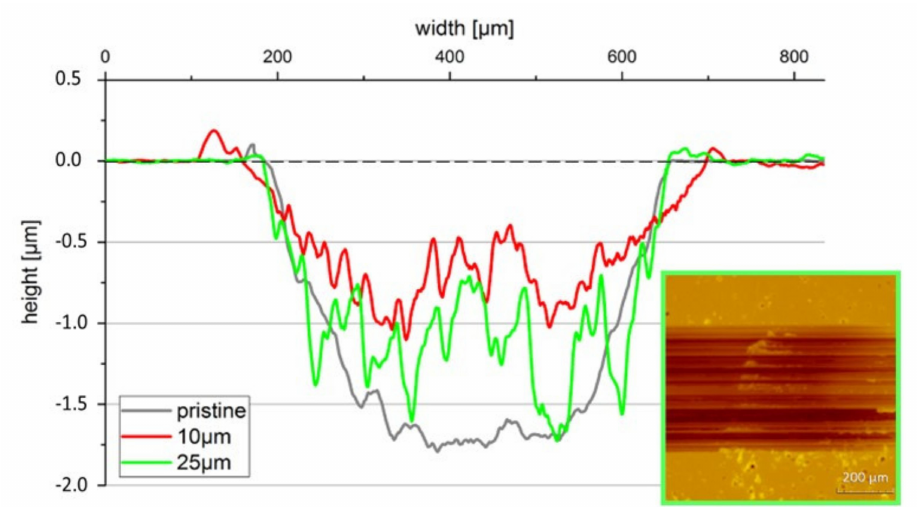
Figure 3. Cross-sectional profiles of the wear tracks after oscillation tribometry. The surfaces on em- bossed substrates (red, green) exhibited a significantly reduced wear volume compared with the pris- tine case (grey). The inset shows the surface topography of the wear track from the 25 µ m